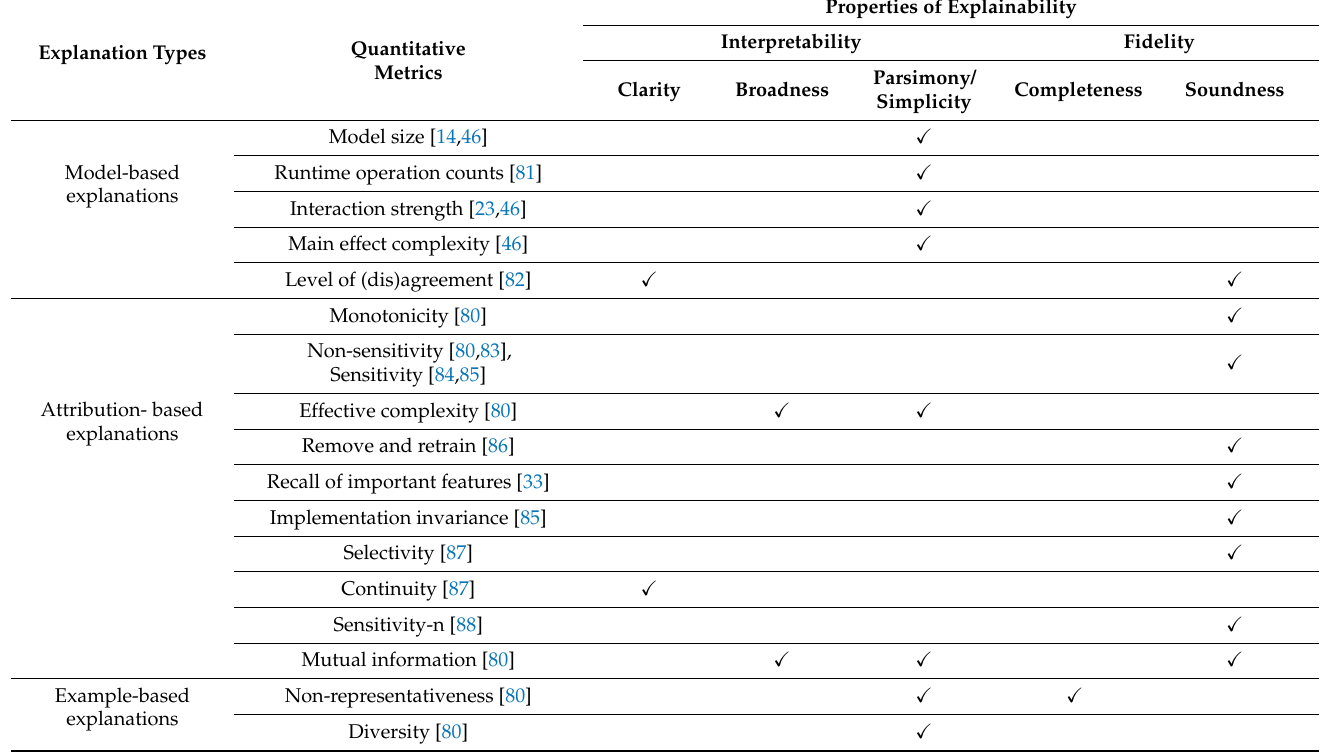
Table 2. Quantitative metrics for machine learning (ML)